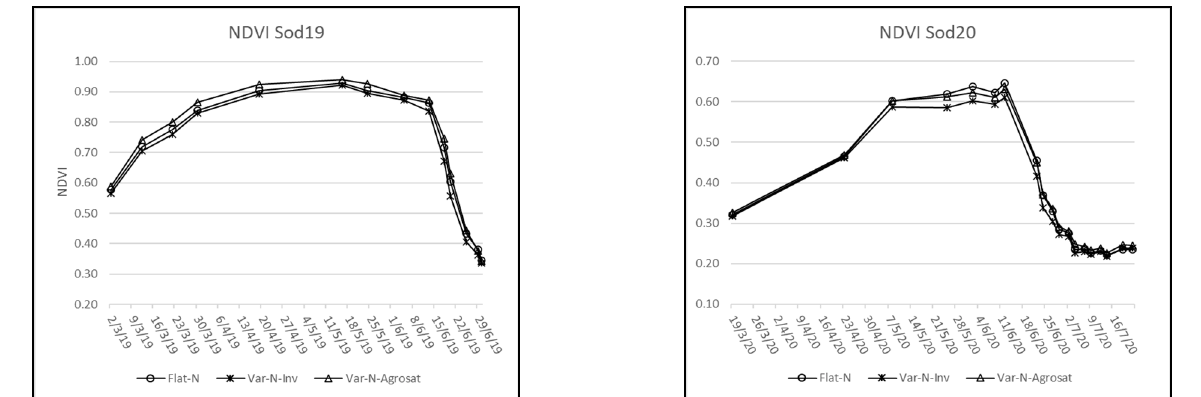
Figure 4. NDVI seasonal trends of the five treatments in the four experimental fields.